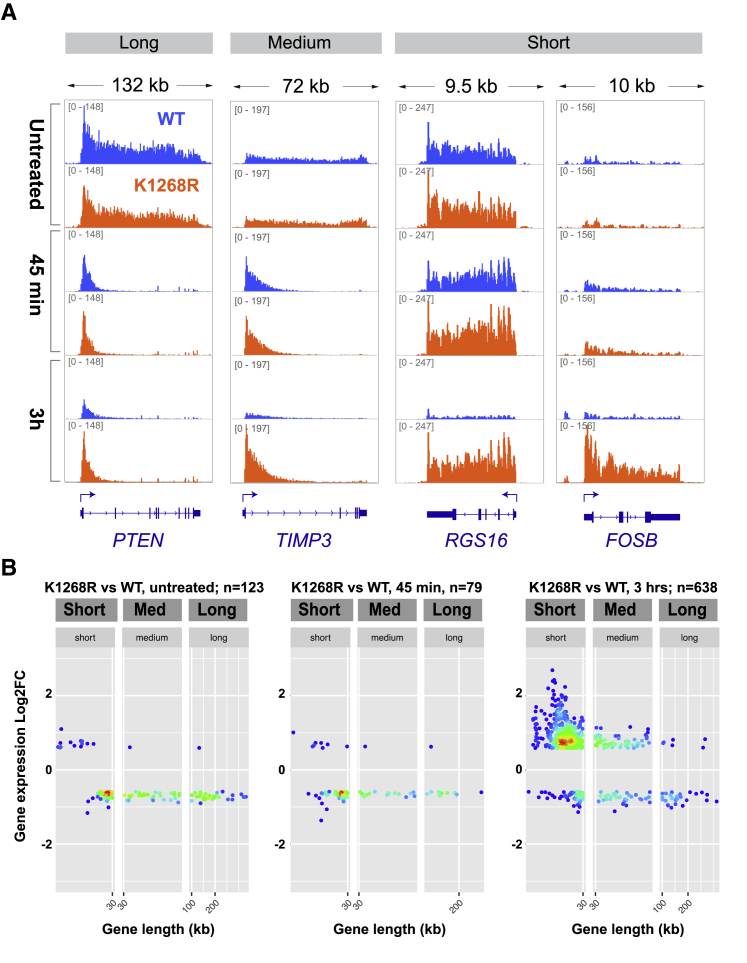
K1268 Ubiquitylation Prevents Short Genes from Escaping the UV-Induced Transcription Shutdown, Related to Figure 4(A) Browser tracks of the TTchem-seq experiment, showing a long (PTEN), a medium (TIMP3) and two short genes (RGS16 and FOSB), before and 45 min or 3 h after UV irradiation. The data are normalized to yeast spike-in.(B) Scatter-density plots showing the genes that are differentially expressed between K1268R and WT cells (TTchem-seq data) stratified by gene length, at different times after UV irradiation (20 J/m2). Each gene is represented by one dot. Plots are colored by binned spot density from low (blue) to high (red).